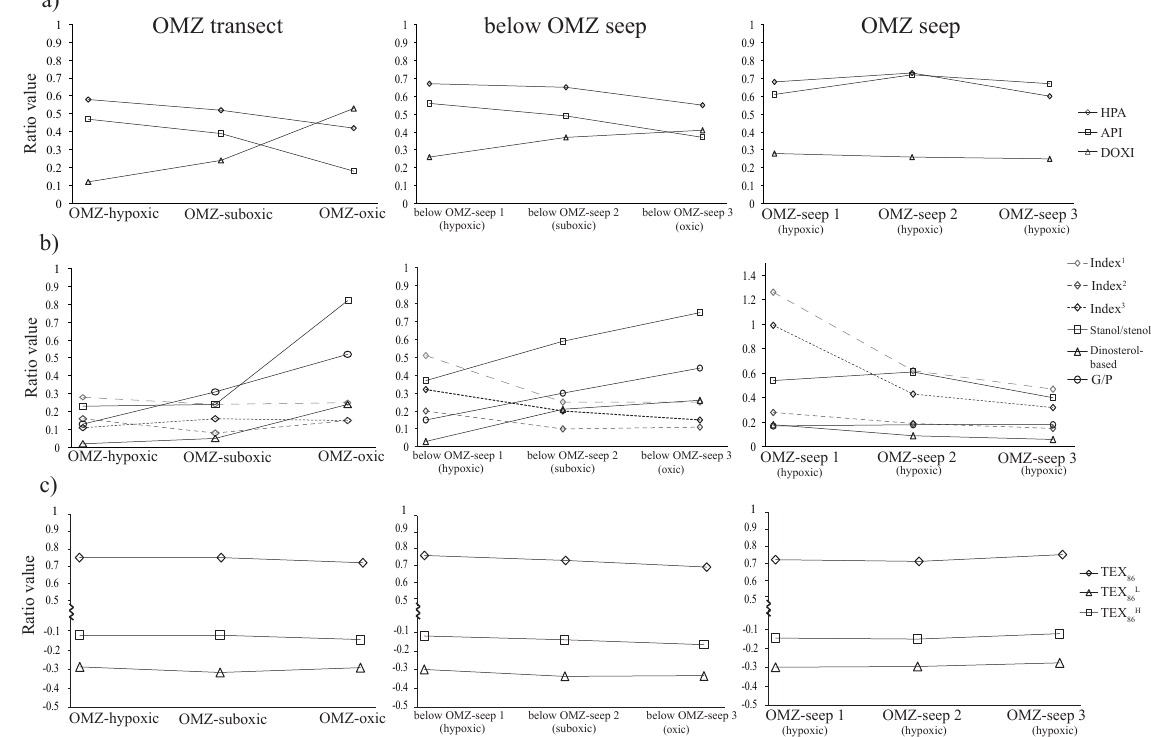
Fig. 5. Proxy ratio trends along the three studied transects of the OMZ transect, below-OMZ-seep, and OMZ-seep, showing ( a) alteration indices, ( b) export production proxies, and ( c) temperature proxies. Note that the scale in ( b) export production proxies of the OMZ-seep transect differs from the other